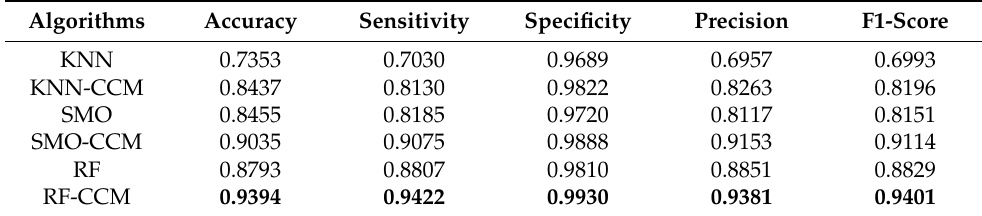
Table 7. The performance metrics comparison between the CCM and non-CCM classifiers.